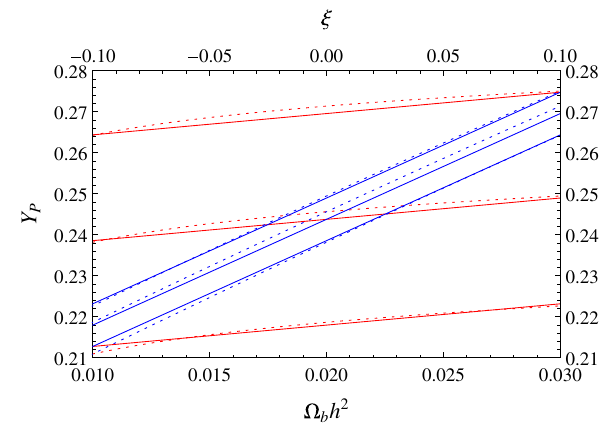
Fig. 1 BBN-predicted curves for Y p in (cid:9) b h 2 ( red ) and ξ ( blue ). From bottom to top , the red curves correspond to ξ = − 0 . 1, 0, − 0 . 1, while the blue curves correspond to (cid:9) b h 2 = 0 . 01, 0 . 02, 0 . 03. The dotted curves are the BBN-predicted results, while the solid curves are our